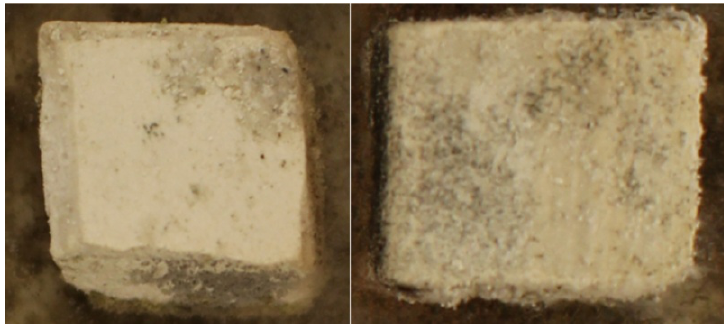
Figure 6. Sample 4 (left) and sample 5 (right) after 41